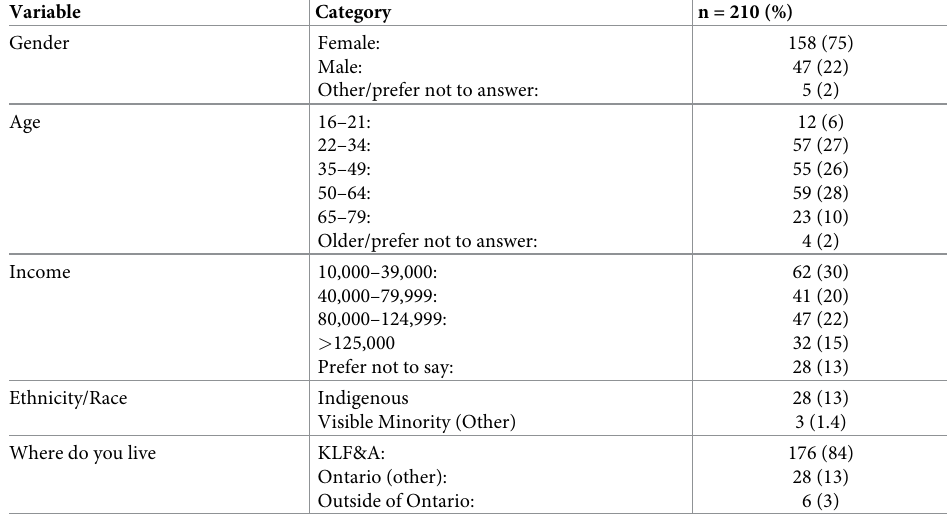
Table 1. Description of the sample providing Spryng.io micronarratives and sociodemographic